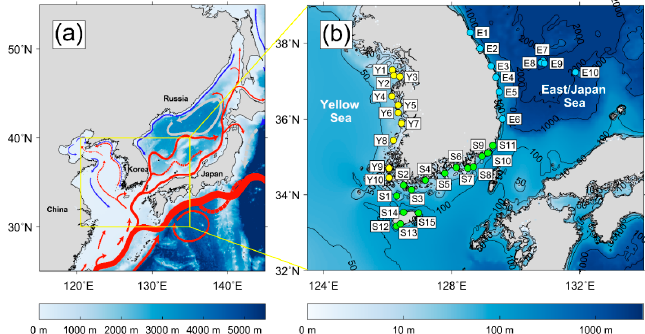
Figure 1. ( a ) Currents in the study area, where the color blue represents water depth; ( b ) enlarged bathymetry map for the seas around the Korean Peninsula. Blue, green, and yellow dots and black text represent the location and symbol of the coastal wave buoys of Korean Meteorological Administration.